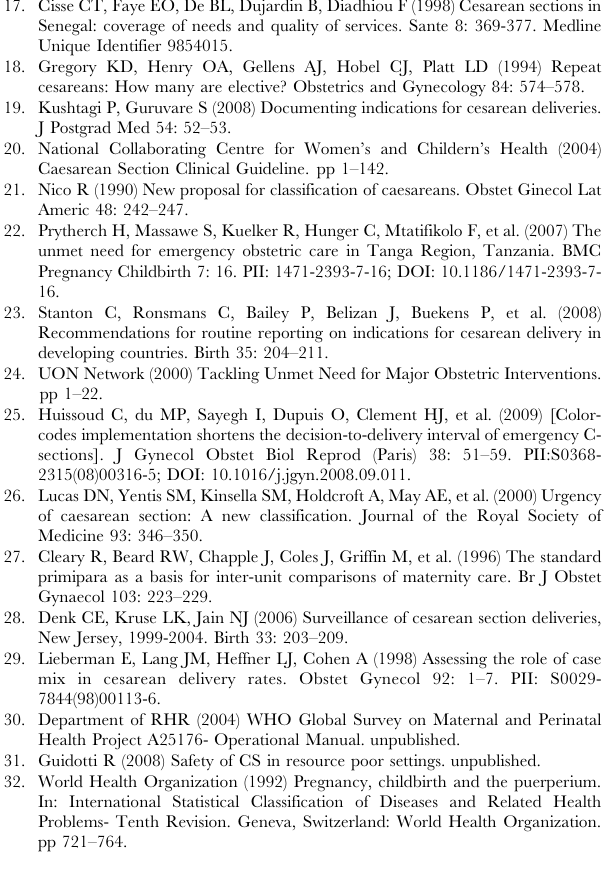
Figure S4 Clinical case scenarios. Twelve clinical case scenarios created to test the existing classifications for Cesarean sections.